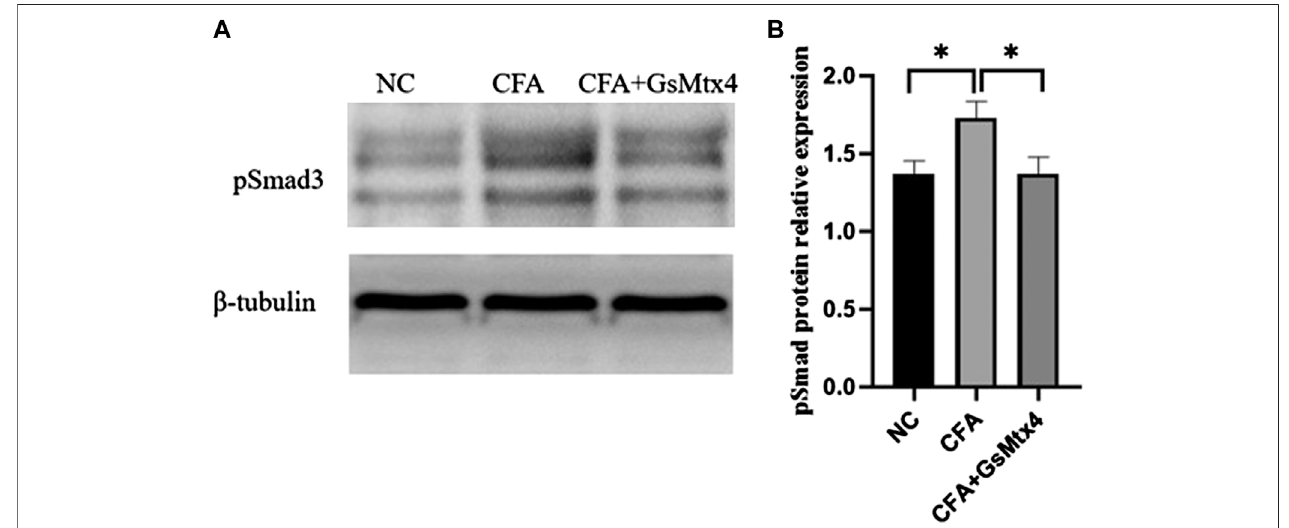
FIGURE 9 | (A) pSmad3 expression in each group; (B) Statistical analysis of the pSmad3 expression in each group. * p <